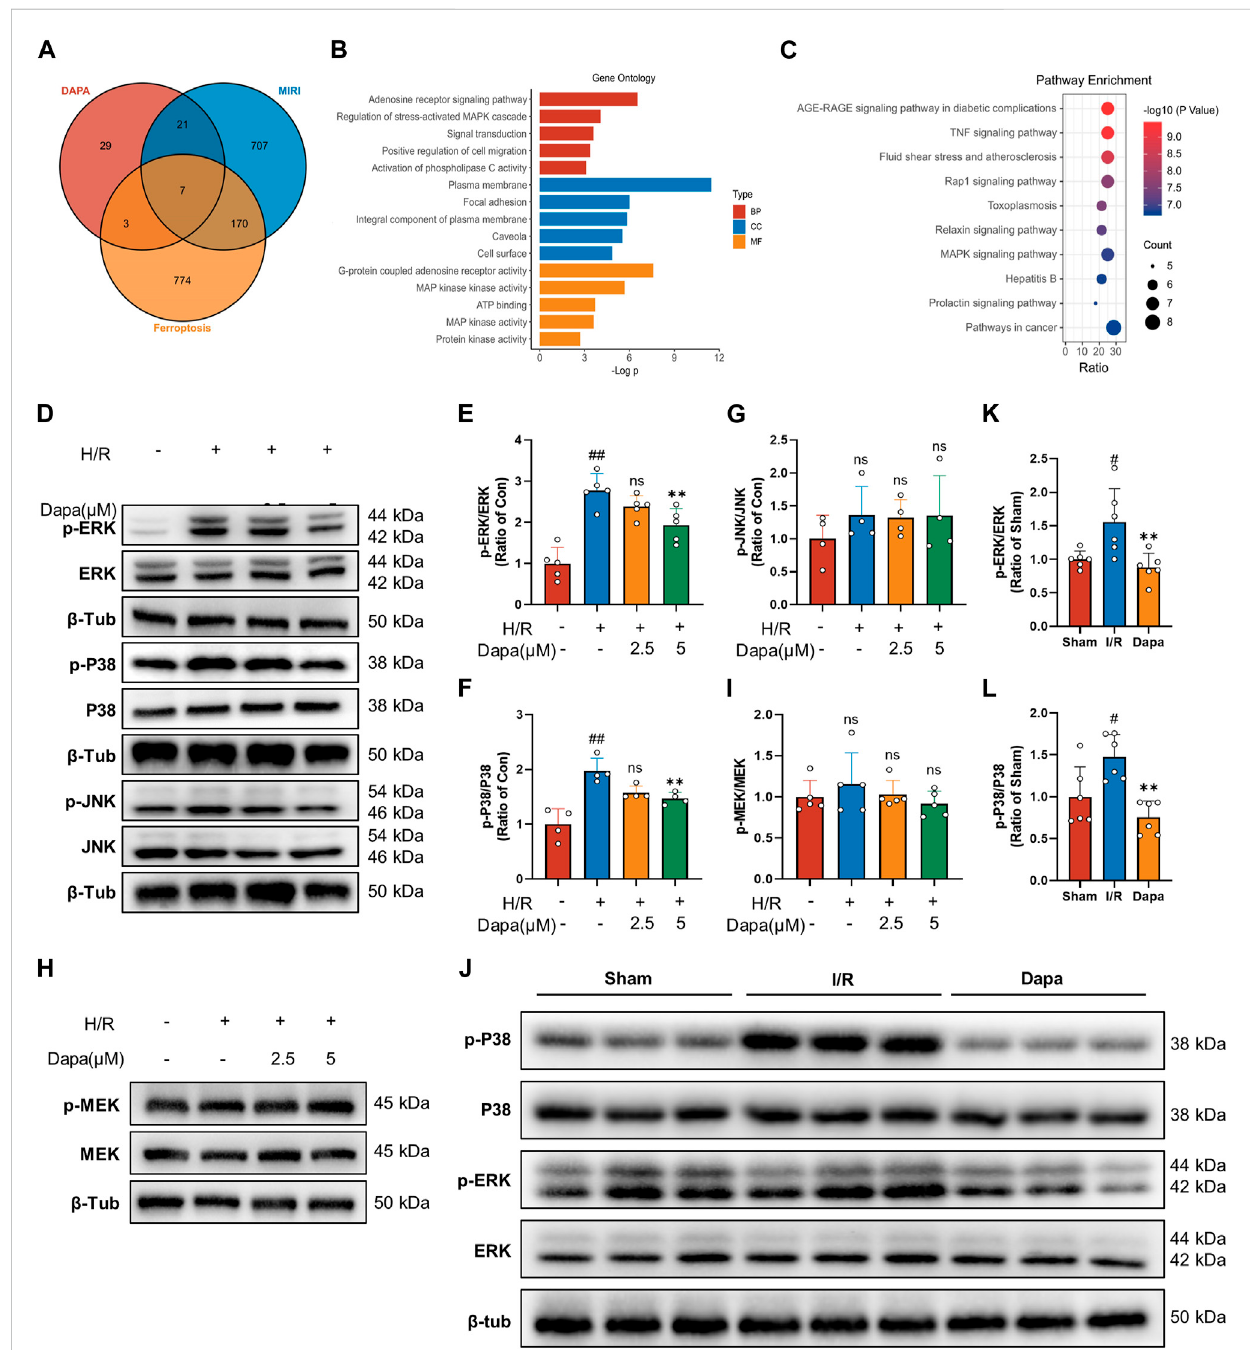
FIGURE 7 The effect of dapagli fl ozin on the MAPK pathway. (A) Venn diagram of dapagli fl ozin potential targets intersecting with MIRI targets and ferroptosis targets. (B, C) GO functional annotation and KEGG pathway analysis. (D – G) Total cell lysates were immunoblotted for phospho-ERK/ERK, phospho-p38 MAPK/p38 MAPK, phospho-JNK/JNK and quantitative analyses ( n = 4, 5 per group). (H, I) The protein levels of phosphor-MEK/MEK were measured by western blotting in vitro ( n = 5 per group). (J – L) Phosphorylated ERK/ERK and phosphorylated p38 MAPK/p38 MAPK in vivo experiments were detected by Western blotting and quantitative analyses ( n = 6 per group). Data are expressed as mean ± SD; One-way ANOVA followed by Tukey ’ s correction for posthoc multiplecomparisonsorDunnett ’ smultiplecomparisontests; # p < 0.05, ## p < 0.01 vsControlgroup( invitro )orShamgroup( in vivo ); * p < 0.05, ** p < 0.01 vs H/R group ( in vitro ) or I/R group ( in vivo